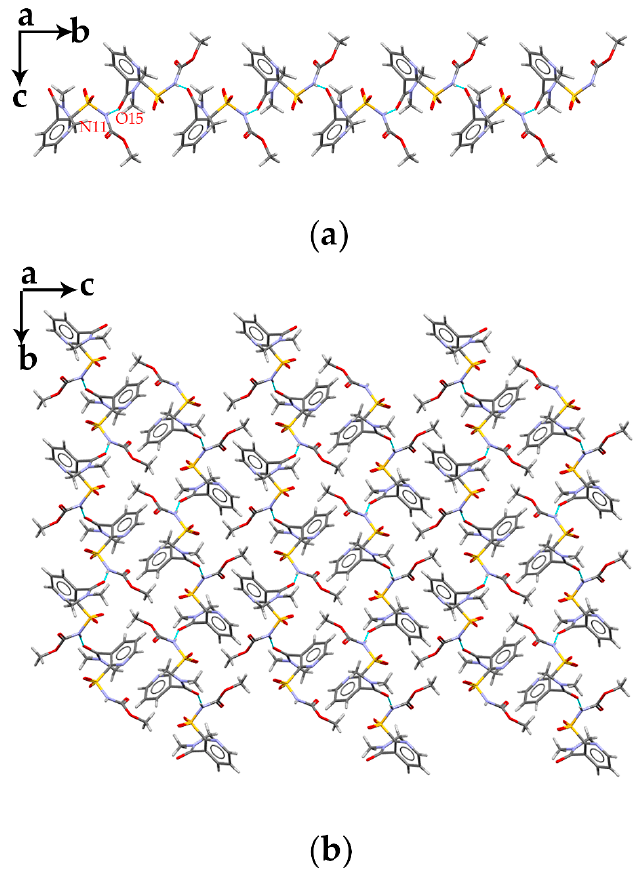
Figure 5. ( a ) 1-D chain formed by the hydrogen bonds along the b axis in